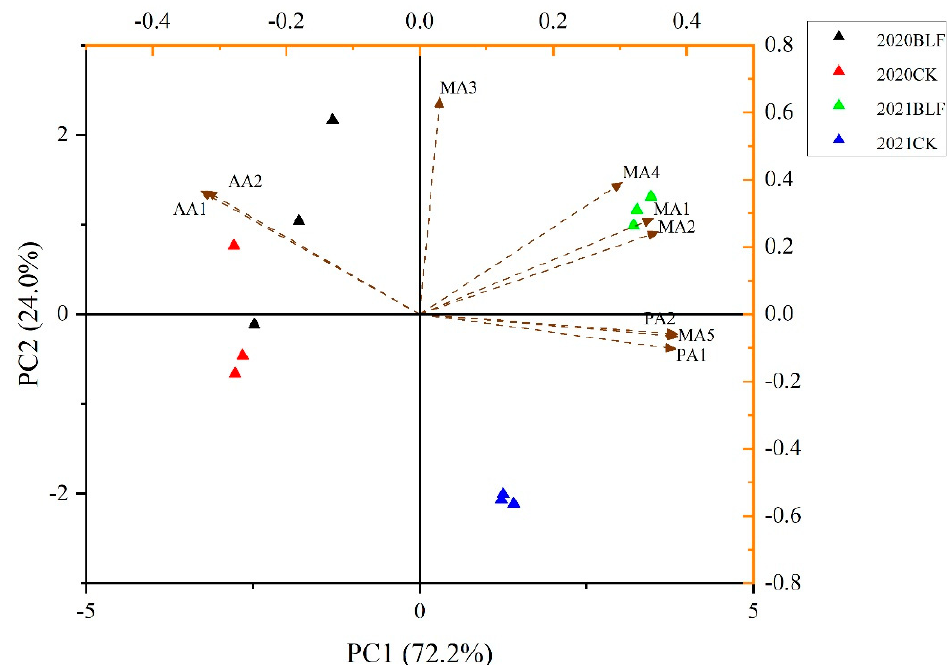
Figure 4. Principal component analysis of anthocyanins in ‘Cabernet sauvignon’ grape skins from BLF and CK treatments in 2020 and 2021. MA1: Delphinidin-3- O -glucoside; MA2: cyanidin-3- O -glucoside; MA3: Petunidin-3- O -glucoside; MA4: Peonidin-3- O -glucoside; MA5: Malavidin-3- O -glucoside; AA1: Peonidin-3- O -(6- O -acetyl)-glucoside; AA2: Malavidin-3- O -(6- O -acetyl)-glucoside; PA1: Trans-Peonidin-3- O -(6- O -p-coumaryl)-glucoside; PA2: Trans-Malavidin-3- O -(6- O -p-coumaryl)-glucoside.